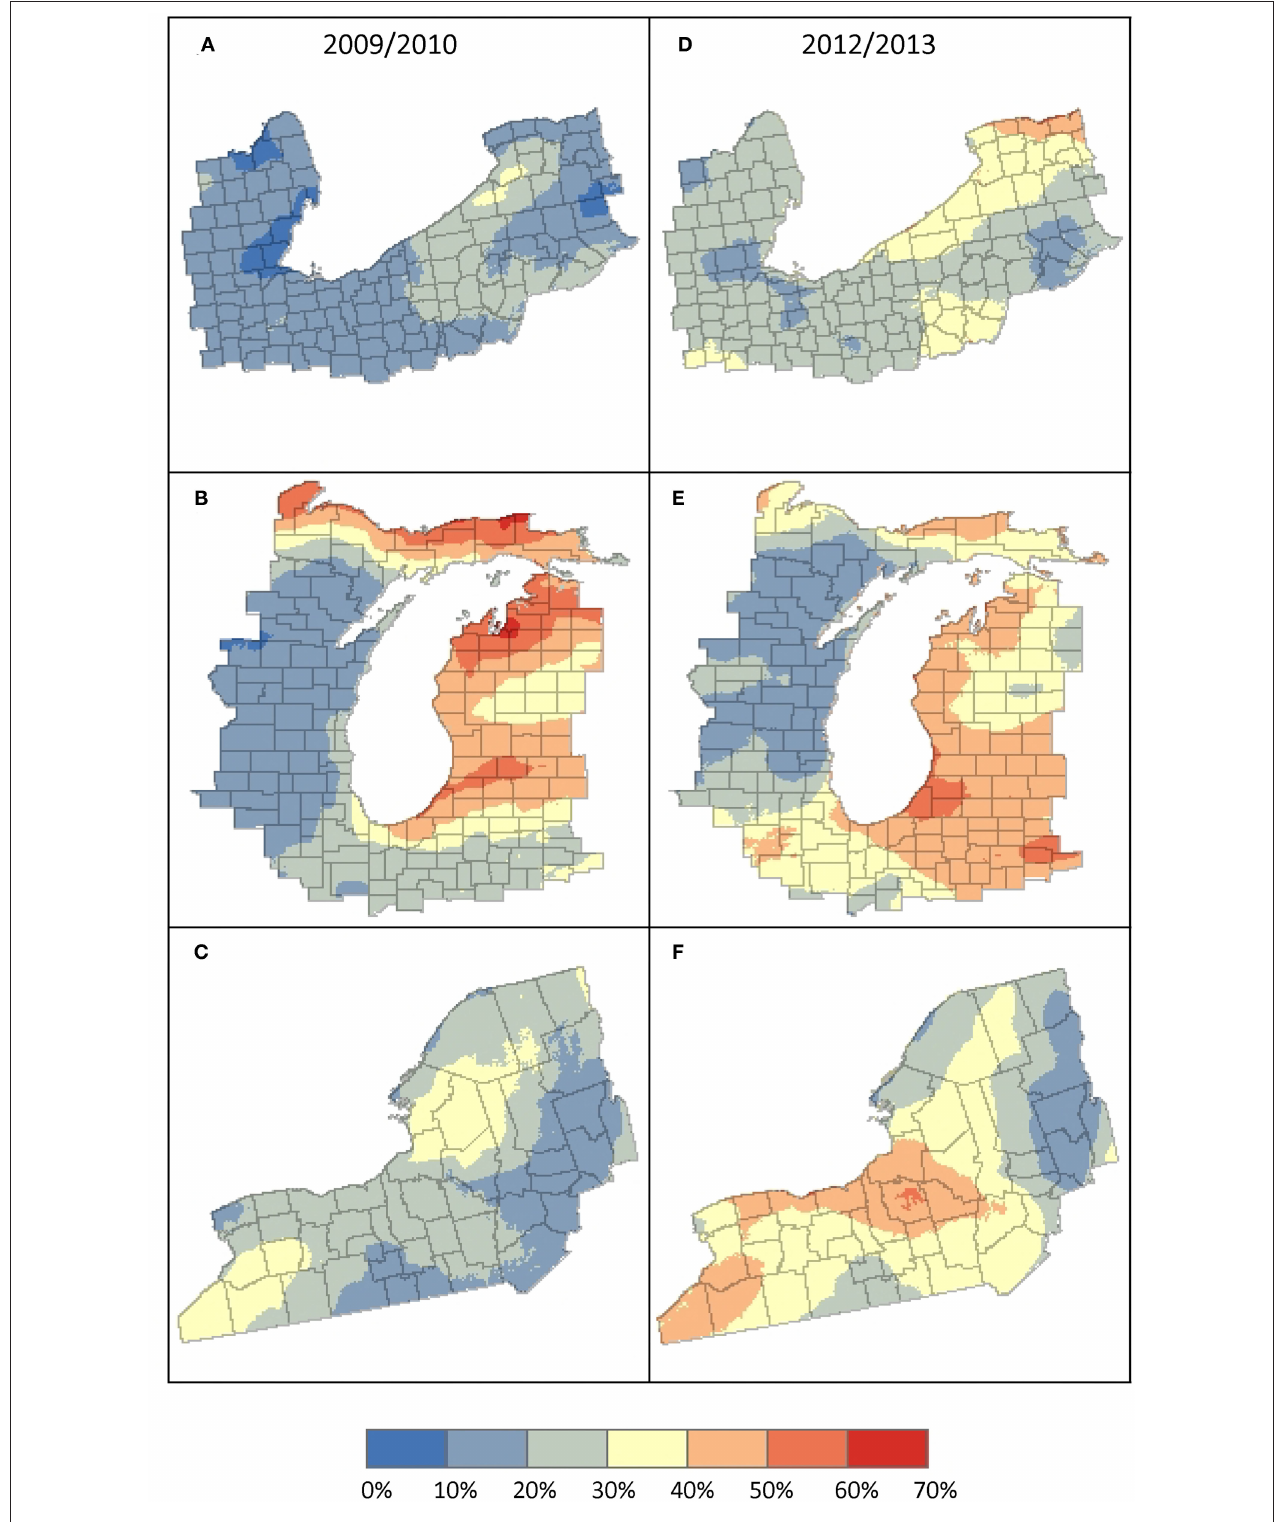
FIGURE 6 | The percentage contribution of LES snowfall (cm) to cold-season snowfall during 2009/2010 for the (A) Lake Erie region, (B) Lake Michigan region, and (C) Lake Ontario region and during 2012/2013 for the (D) Lake Erie region, (E) Lake Michigan region, and (F) Lake Ontario region.